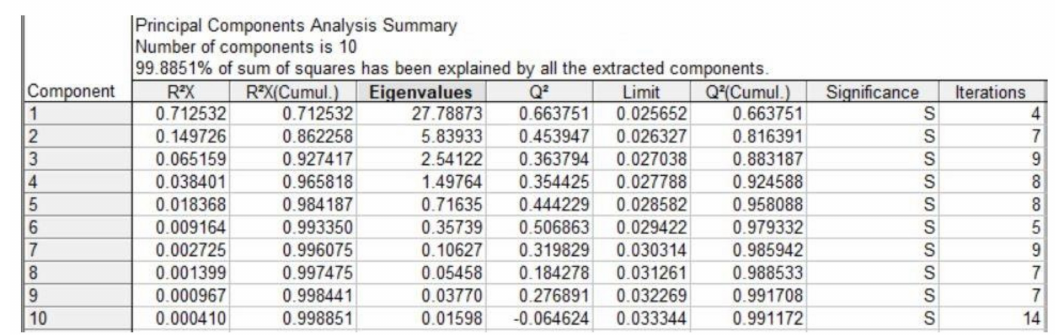
Figure 2. The explained variation (R 2 X) and the predictive variation (Q 2 X) of the PCA components. Each principal component is a linear combination of the variables from the whole data set. A total of 90,720 descriptors for each component and each method were analysed, or a total of 3.538.080